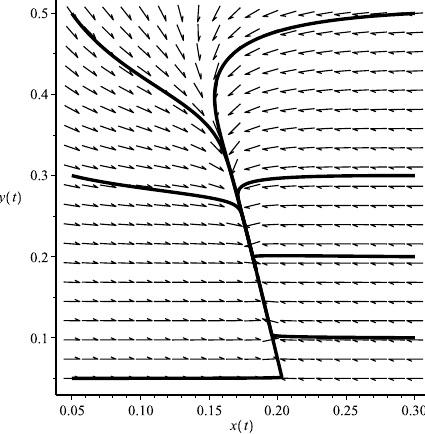
Figure 2: Dynamic behavior of system (5.2), here the initial condition ( x (0), y (0)) = (0.05, 0.5) , (0.05, 0.3), (0.05, 0.5) , (0.3, 0.1) , (0.3, 0.3) , (0.3, 0.5) and (0.3, 0.2) , respectively.